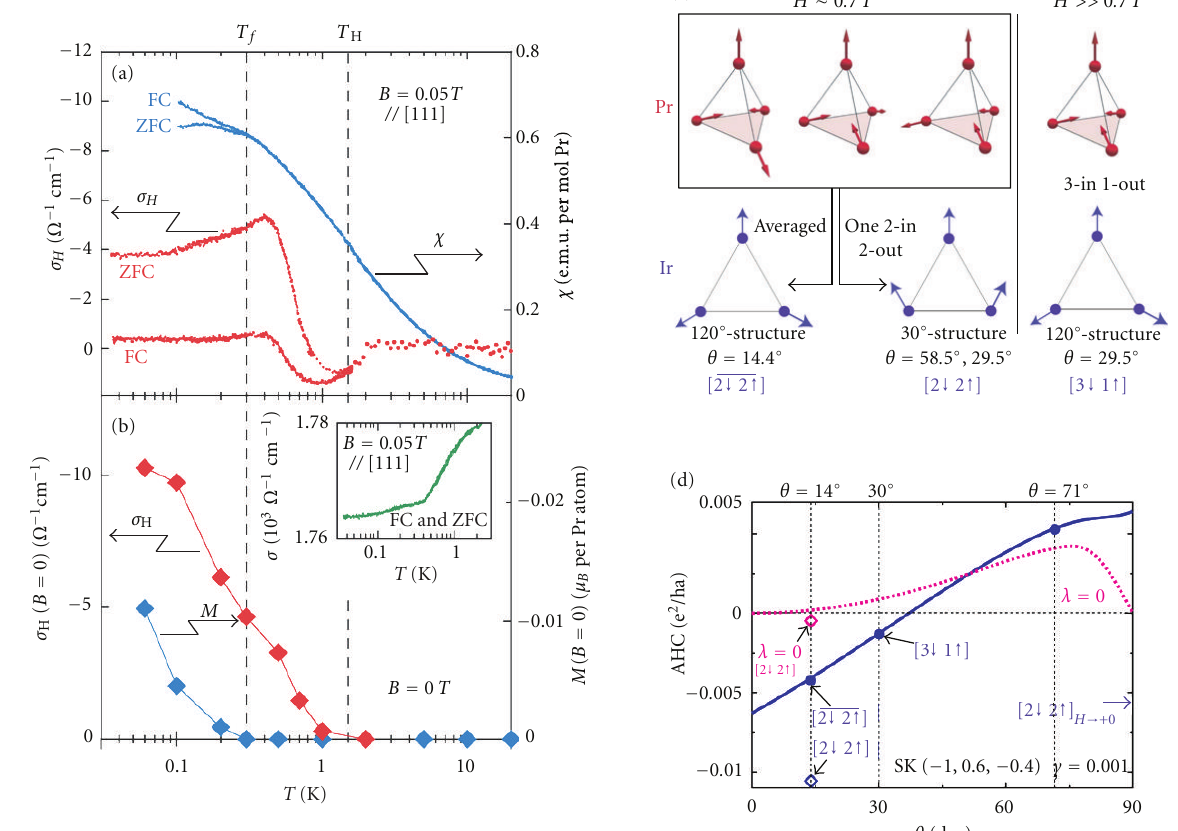
Figure 7: (a) Zero-field-cooled/field-cooled temperature dependence of the Hall conductivity (left axis) and magnetic susceptibility (right axis), measured in a field of B = 0 . 05 T along the [111] direction of Pr 2 Ir 2 O 7 single crystals. Bifurcation of σ H at T H occurs above any magnetic ordering temperature observed in χ . (b) Zero-field temperature dependence of σ H and magnetisation, M . A spontaneous Hall conductivity occurs at T H in the absence of any magnetic moment, which does not appear until below T f . Figures are from [6]. (c) The induced Ir spin structures from the “2-in, 2-out” and “3-in, 1-out” Pr tetrahedra in Pr 2 Ir 2 O 7 , taken from [4]. (d) Calculated θ -dependence of the anomalous Hall coe ffi cient for various spin structures in Pr 2 Ir 2 O 7 , using the SK d - d hopping integrals shown. The nonzero values obtained at θ = 0 and 90 ◦ , where the spin chirality term is zero, indicate that the spin chirality mechanism is not the dominant mechanism, taken from